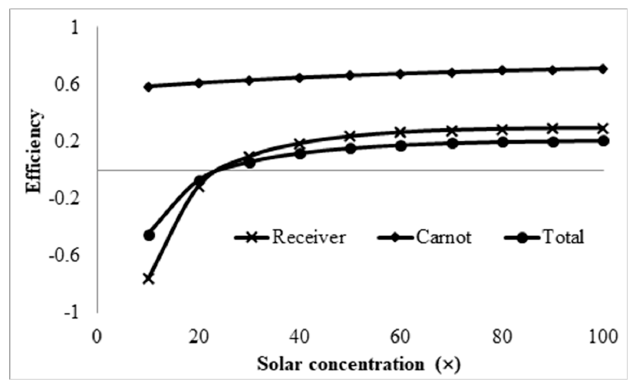
Figure 16. Effect of solar concentrations on receiver, Carnot, and total efficiencies. Figure 16. E ff ect of solar concentrations on receiver, Carnot, and total e ffi